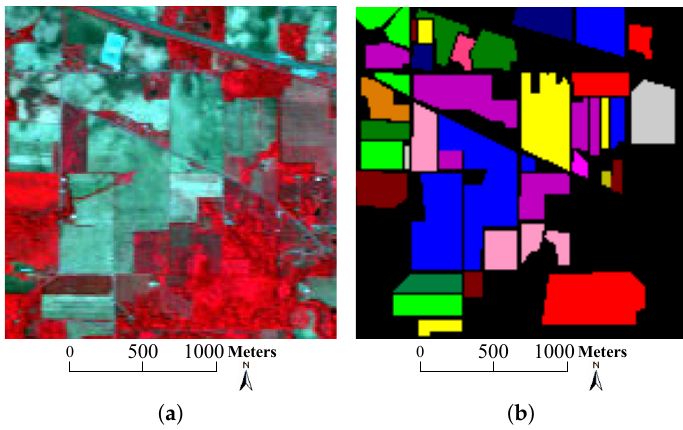
Figure 6. Indian Pines data. ( a ) Three-band false color composite and ( b ) ground truth data with 16 classes. Table 1. Number of samples (NoS) used in the Indian Pines data.